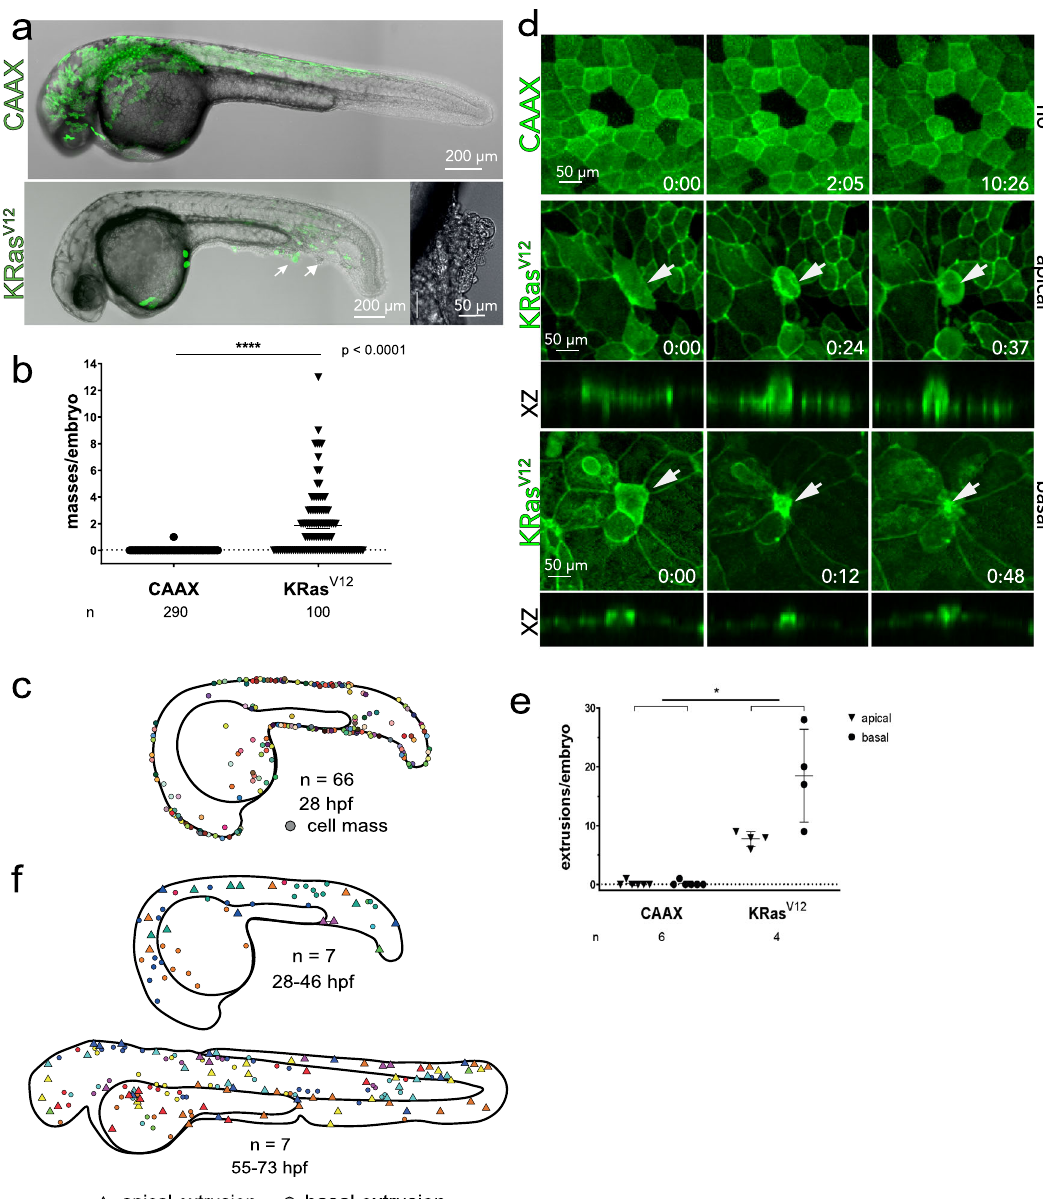
Fig. 1 KRas V12 induces formation of epidermal cell masses and basal extrusion at distinct sites. a 26 hpf wild-type zebra fi sh embryos expressing krt4 :EGFP-CAAX or dt-KRas V12 , masses indicated by black arrowheads and inset. b Mean of cell masses per embryo± SEM, P < 0.0001 by a Mann – Whitney test, n = embryos. c Map of where cell masses occur, as observed at 28 hpf. d Stills from time-lapse imaging (hh:mm) of periderm:Lifeact- EGFP mosaically expressing EGFP-CAAX or EGFP-dt-KRas V12 , showing hallmarks of apical and basal extrusion, with XZ sections beneath showing constriction at the base or apex, respectively (white arrows delimit ring constricting). e Number of apical and basal extrusions in EGFP-CAAX or dt-KRas V12 embryos. Data are mean ± SEM, ** P < 0.02 by a Mann – Whitney test for apical and basal extrusions pooled together. f Maps indicating where apical and basal extrusions occur in 28-46 hpf embryos and 55 – 73 hpf embryos, where different colours represent different fi sh analyzed, n. Source data are provided as a Source Data fi